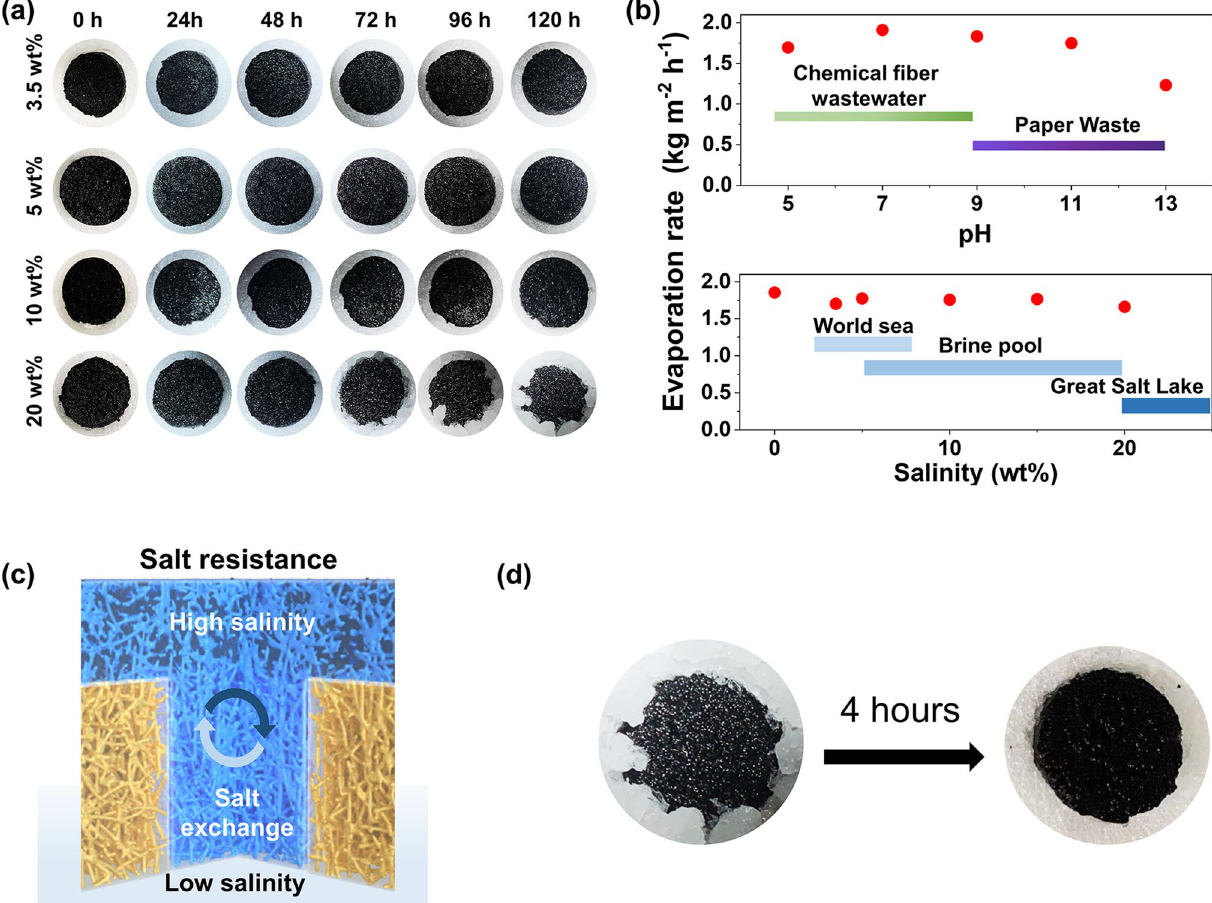
Fig. 7 Salt rejection performance. a Digital photoes showing salt-resistance of our evaporator with 120 h-continuous operation. b Endurance measurement at the extreme pH and high salinity. c Working mechanism of salt diffusion in our evaporators for self-cleaning. d Digital photos showing salt resistance of our evaporator even a large amount of salt crystals accumulated on the edge of the